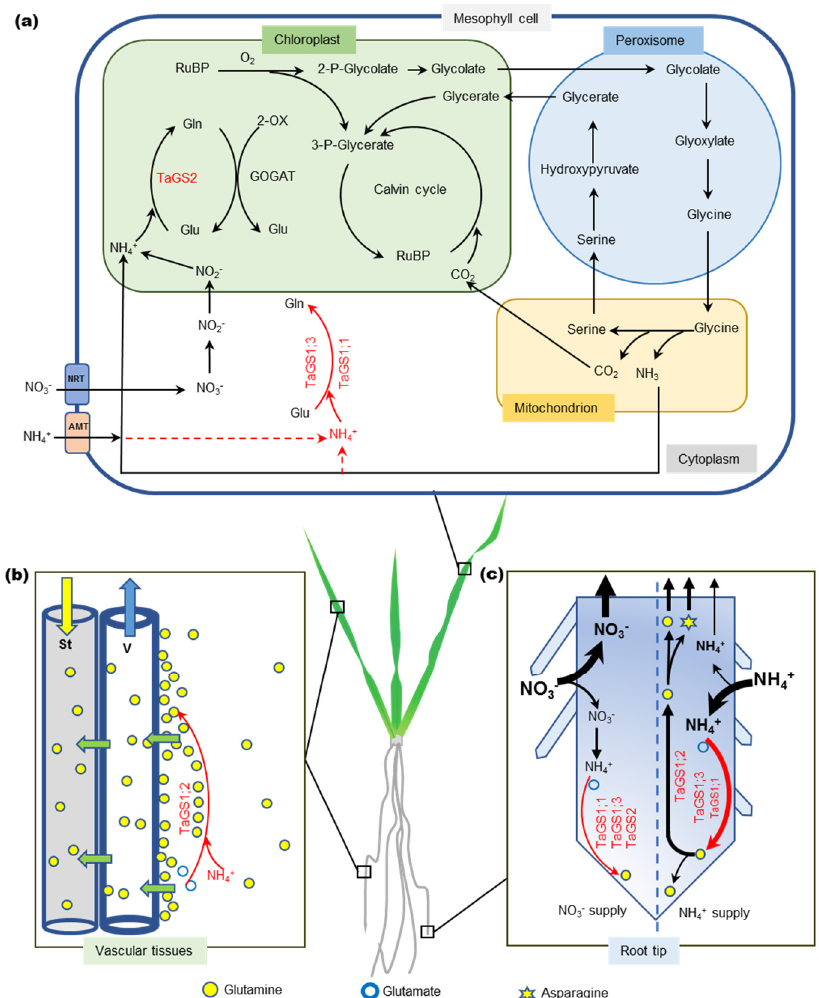
Figure 6. Schematic model of new functions of TaGS isoforms. ( a ) TaGS1;1 and TaGS1;3 were located in mesophyll and may participate in cytoplasmic assimilation of NH 4 + released from photorespiration or absorbed by roots. ( b ) TaGS1;2 was located in vascular tissue of leaf and root and activated by Gln, hence responsible for nitrogen transport. ( c ) Under NO 3 − supply ( left ), NO 3 − stimulated TaGS1;1, TaGS1;3, and TaGS2 expression in root tip meristem and participated in assimilation of NH 4 + from NO 3 − reduction. Under NH 4 + supply ( right ), TaGS1;3, with the highest V max , and TaGS1;1 were induced by NH 4 + to express in root tip endodermis and may participate in relieving NH 4 + toxicity. A large amount of TaGS1;2 was distributed in root tip vascular tissue, helping to transport Gln to shoots. NRT, nitrate transporter; AMT, ammonium transporter; St, sieve tube; V, vessel.